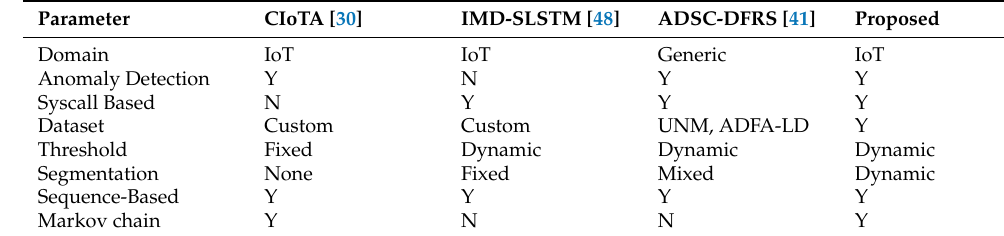
Table 4. Comparison of characteristics of related anomaly detection approaches with the proposed approach.